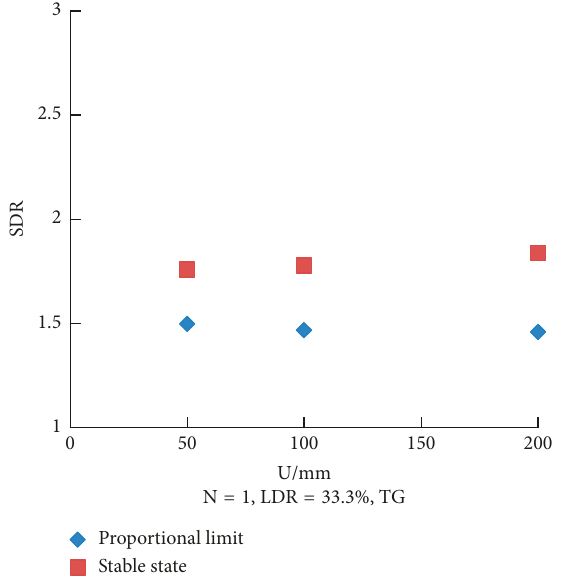
Figure 17: The relationship between SDR and U (TG; N LDR 33.3%). (cid:30)